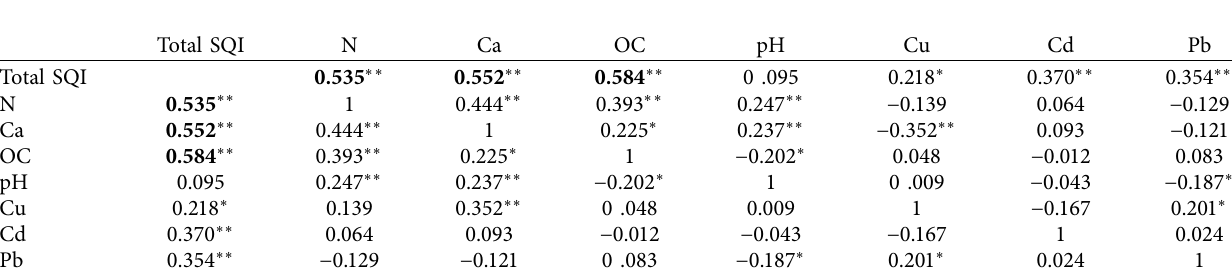
Table 7: Correlations of SQI and soil parameters ( n �